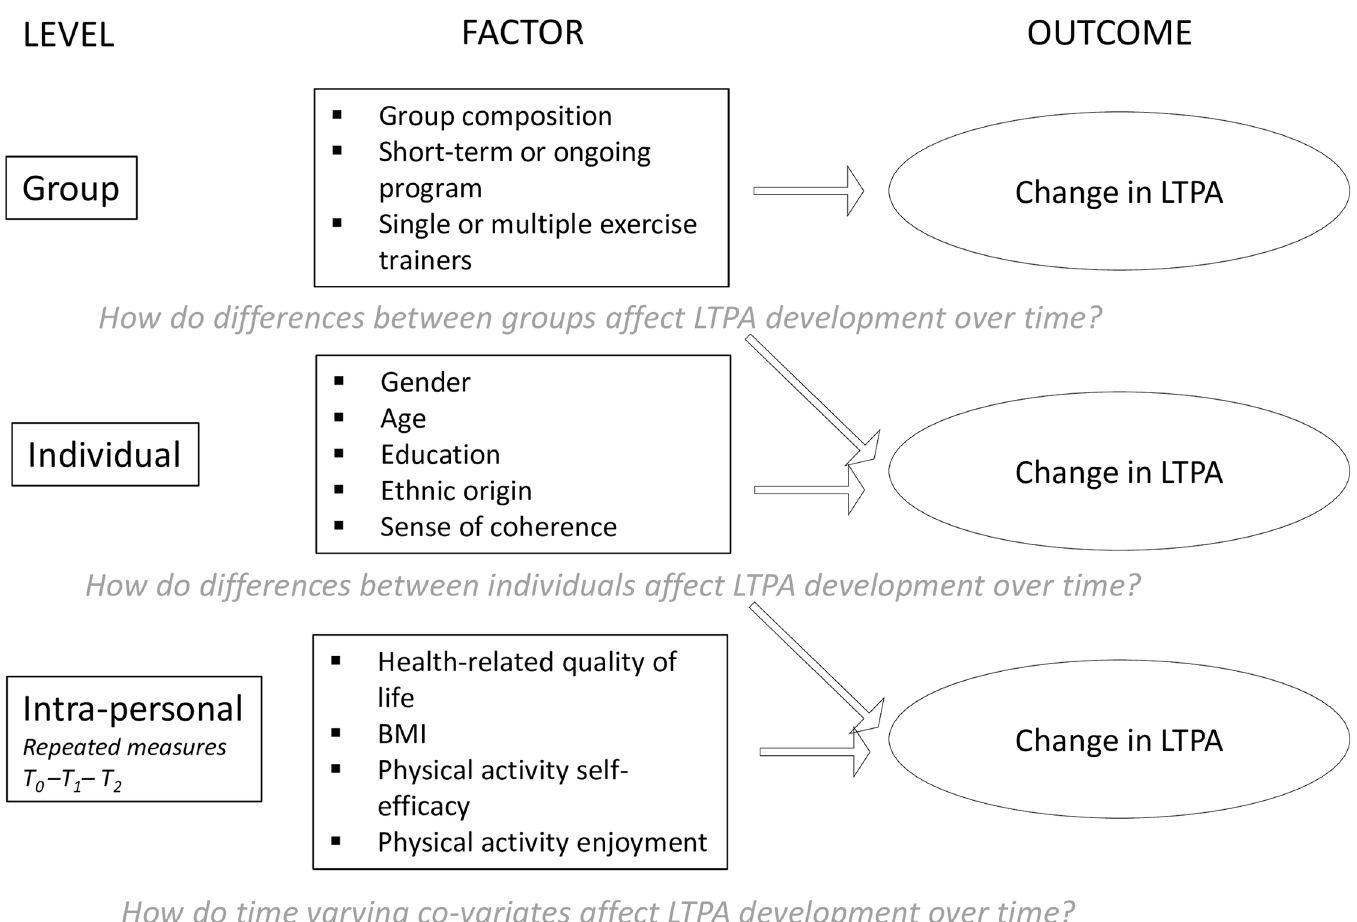
Fig 2. Multilevel perspective on change in LTPA through CBHEPA programs (after Heck et al.